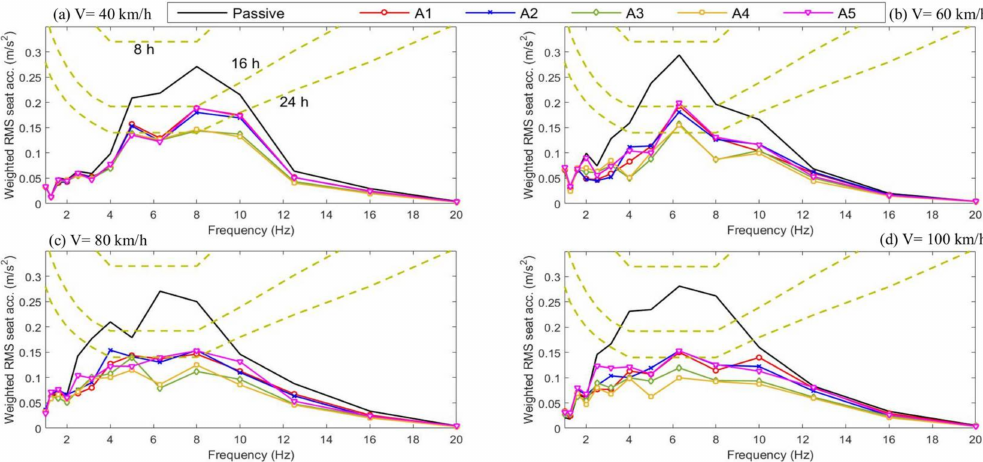
Figure 19. Performance assessment of the proposed active seat suspensions under different vehicle speeds. ( a , b ) SEAT factor and percentage improvements, respectively ; ( c , d ) Frequency-weighted RMS seat acceleration and percentage improvements.